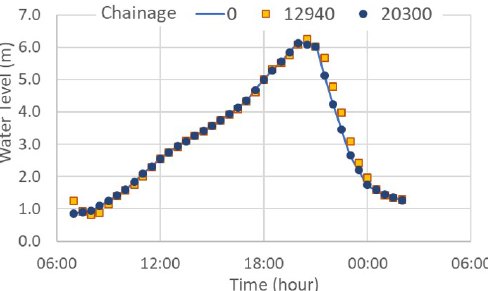
Figure 6. Variation of water level at three locations (chainage 0, 12940 and 20300) along the 1-D channel on the seaside according to a specific scenario (out of 72